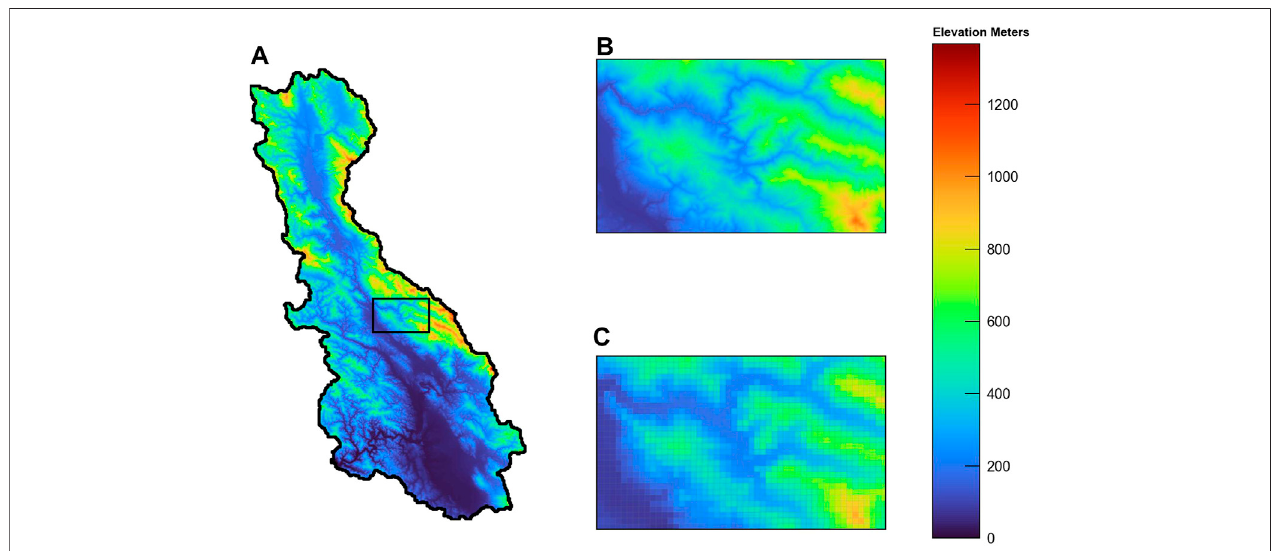
FIGURE 2 | Digital elevation model (27.28 m x 27.28 m; DEM; U.S. Geological Survey, 2020) of the Russian River study area (A) . DEM values were resampled by minimum elevation to model grid size (300 m × 300 m) and are shown for a subset of the watershed: the raw DEM data (27.8 m resolution) (B) and the resampled DEM values (300 m resolution) (C) correspond to the inset box in (A)